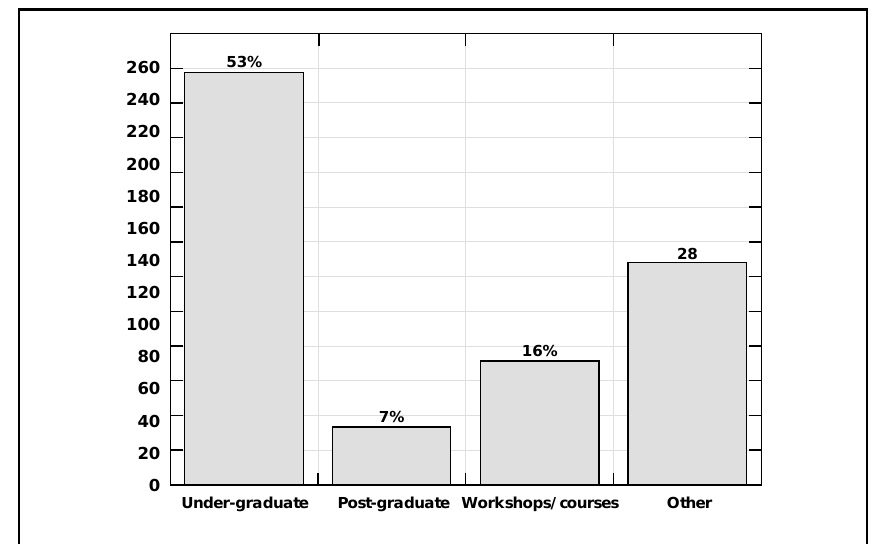
Figure 1: Training in pharmacology.